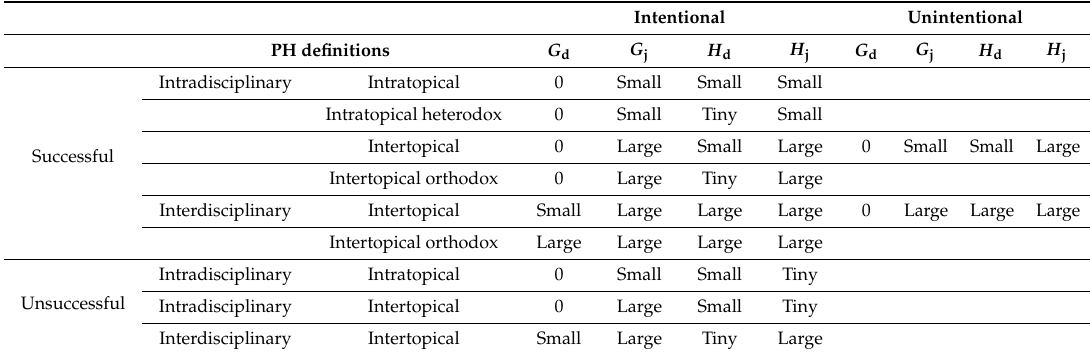
Table 2. Summary of publication history (PH) characterizations in terms of key parameters. H d = H index for di ff erent disciplines, G d = G index for di ff erent disciplines, H j = H index for di ff erent journals, and G j = G index for di ff erent journals. Approximately, small G d = ≤ 0.2; small G j = ≤ 0.6; tiny H d ≤ 1; small H d for 1 < H d ≤ 3; tiny H j ≤ 2; small H j for 2 < H j ≤